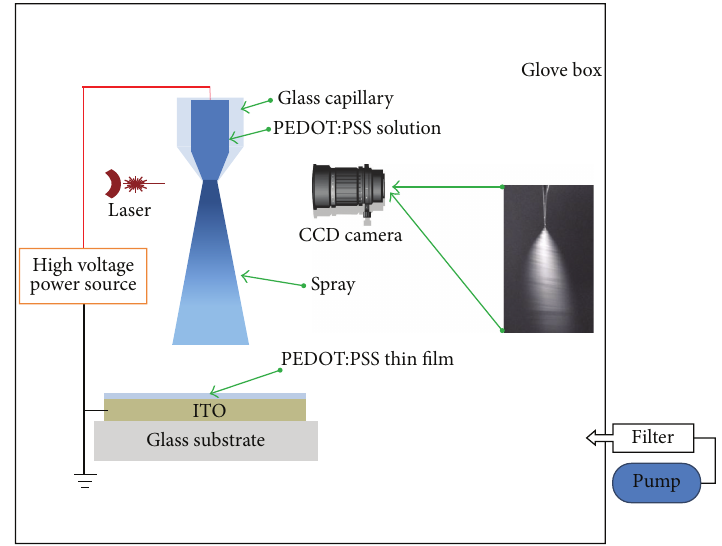
Figure 1: A schematic diagram of the electrospray deposition